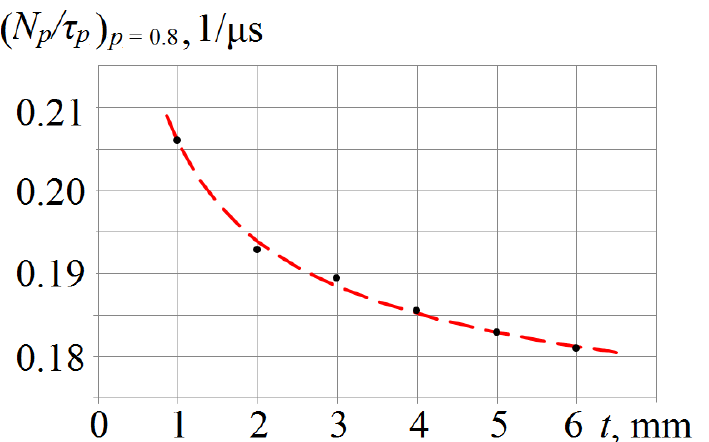
Figure 9. The influence of the specimen thickness t on the p = 0.8 level quantile values of the em- pirical count frequency distribution function N p /τ p of AE signals.